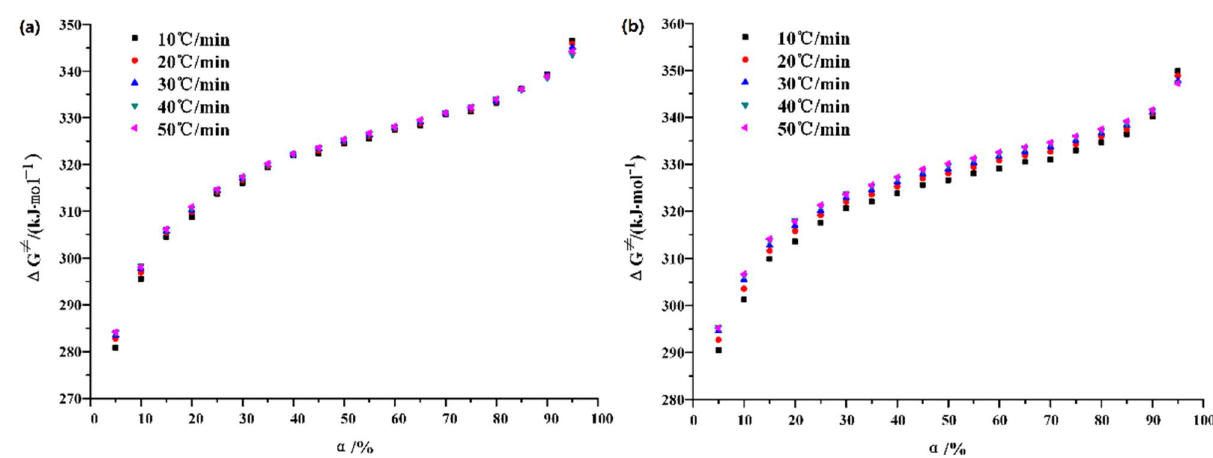
Figure 8. Transitional Gibbs free energy ΔG ≠ varies with conversion ( a ) N 2 and ( b ) CO 2